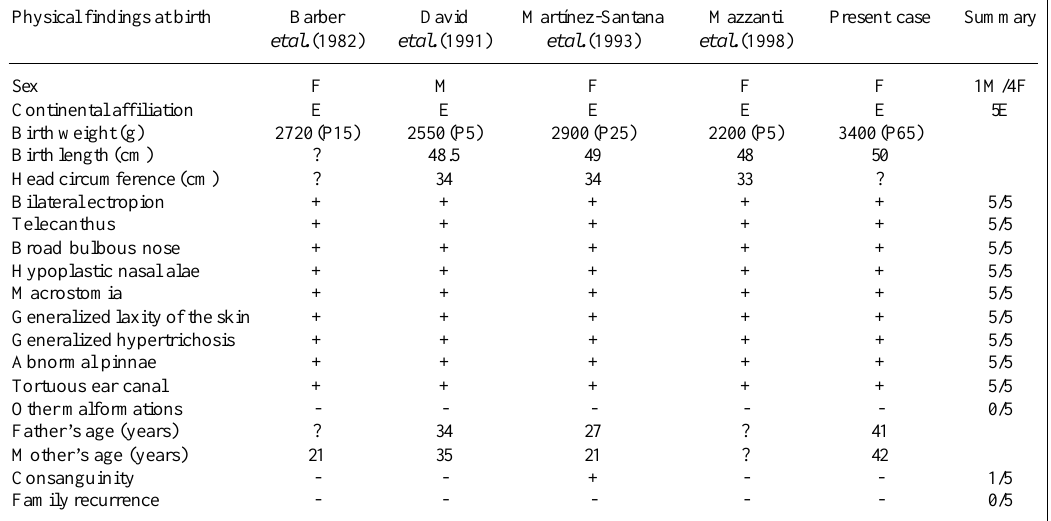
Table I - Comparison among similar previously described patients and the present case.